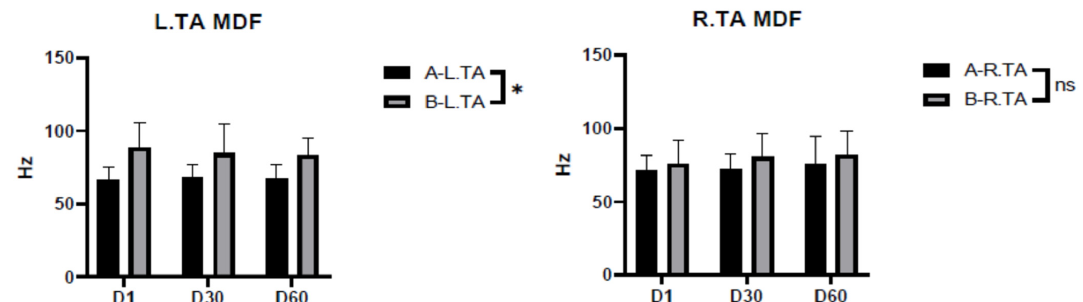
Figure 2. Median frequency (MDF) of the tibialis anterior muscle while wearing shooting shoes and while wearing sports shoes. Note: ns indicates p > 0.05, which is no significant difference; * indicates p < 0.05, which is significant; A indicates shooting shoes; B indicates sports shoes; L indicates left; R indicates right; TA indicates tibialis anterior muscle; and D1/D30/D60 indicate times.